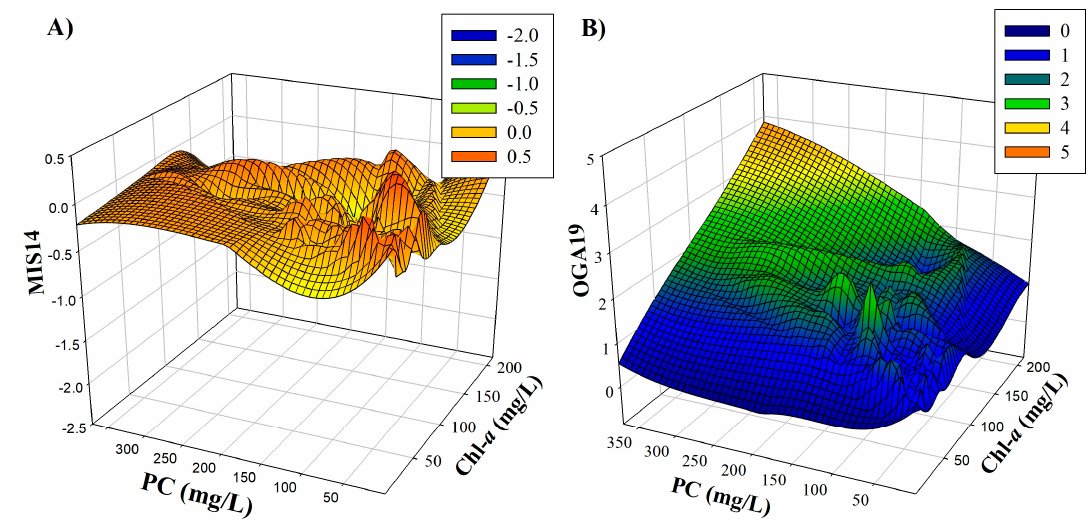
Figure 7. Sensitivity analysis of MIS14 ( A ) and OGA19 ( B ) when applied to the MR data collected in years 2005–2007 and 2010.